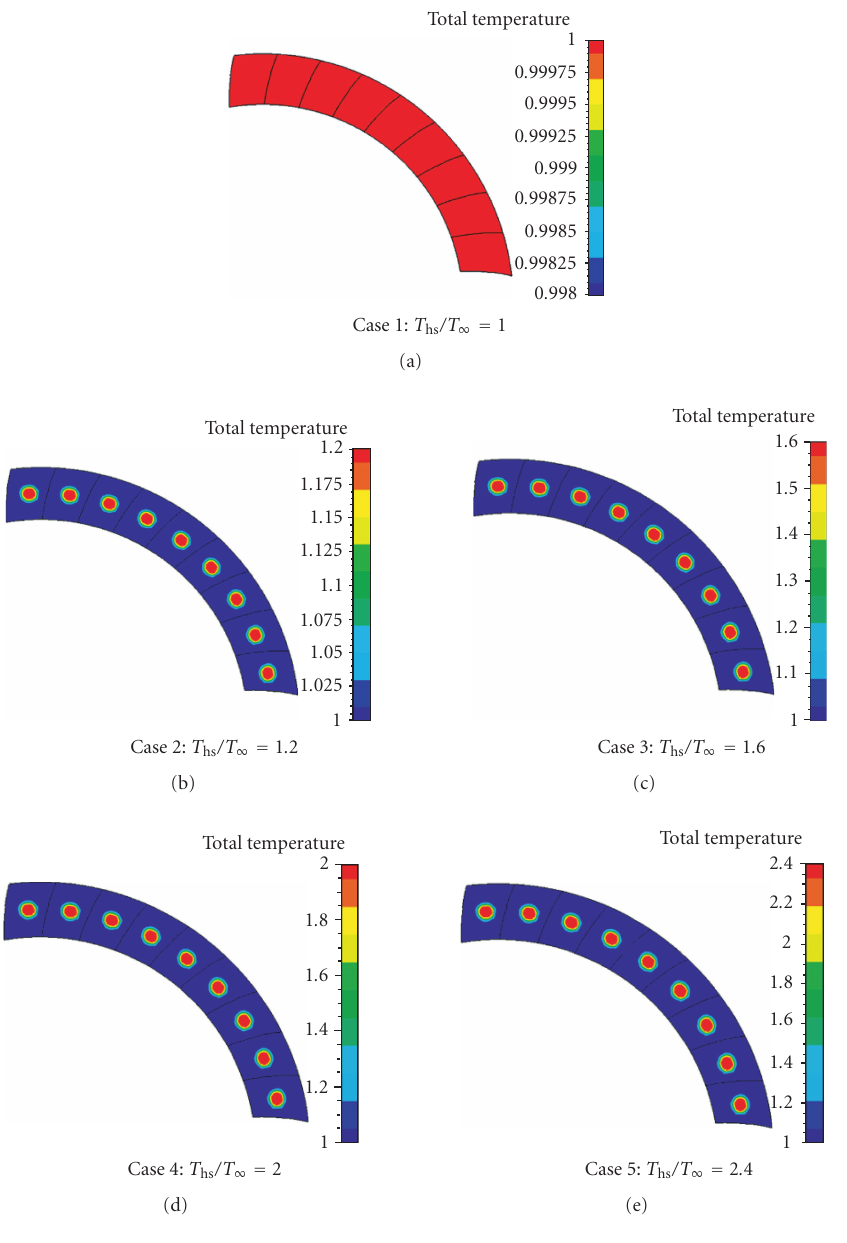
Figure 8: Hot streak